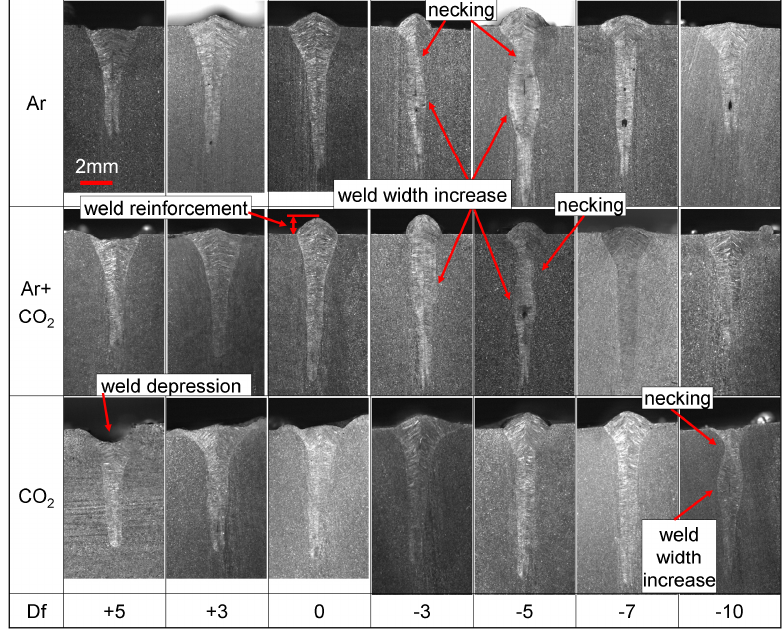
Figure 4. Cross section geometry of weld joints under different shielding gases and Df . (All cross-sections have the same scale of 2 mm).